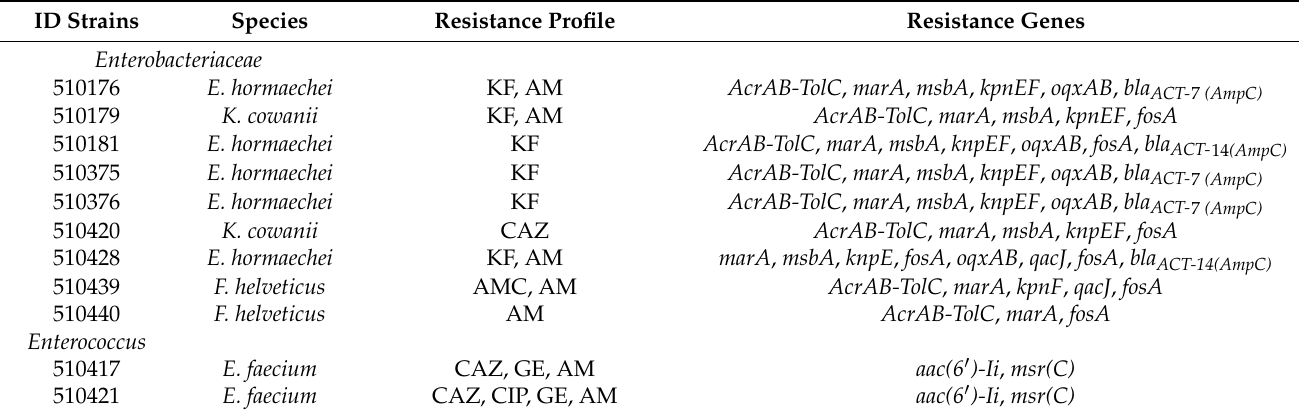
Table 3. Antibiotic resistant gene profiles of the Enterobacteriaceae and Enterococcus